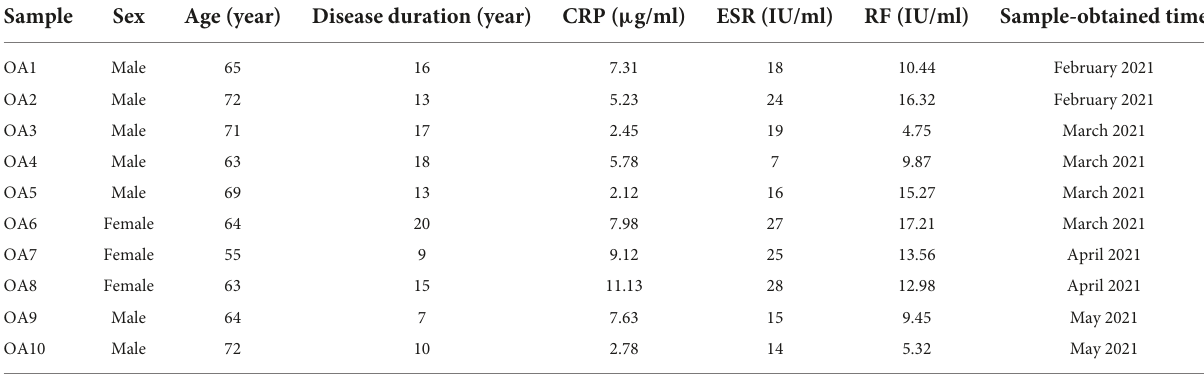
TABLE 1 Clinical characteristics of osteoarthritis (OA) patients.